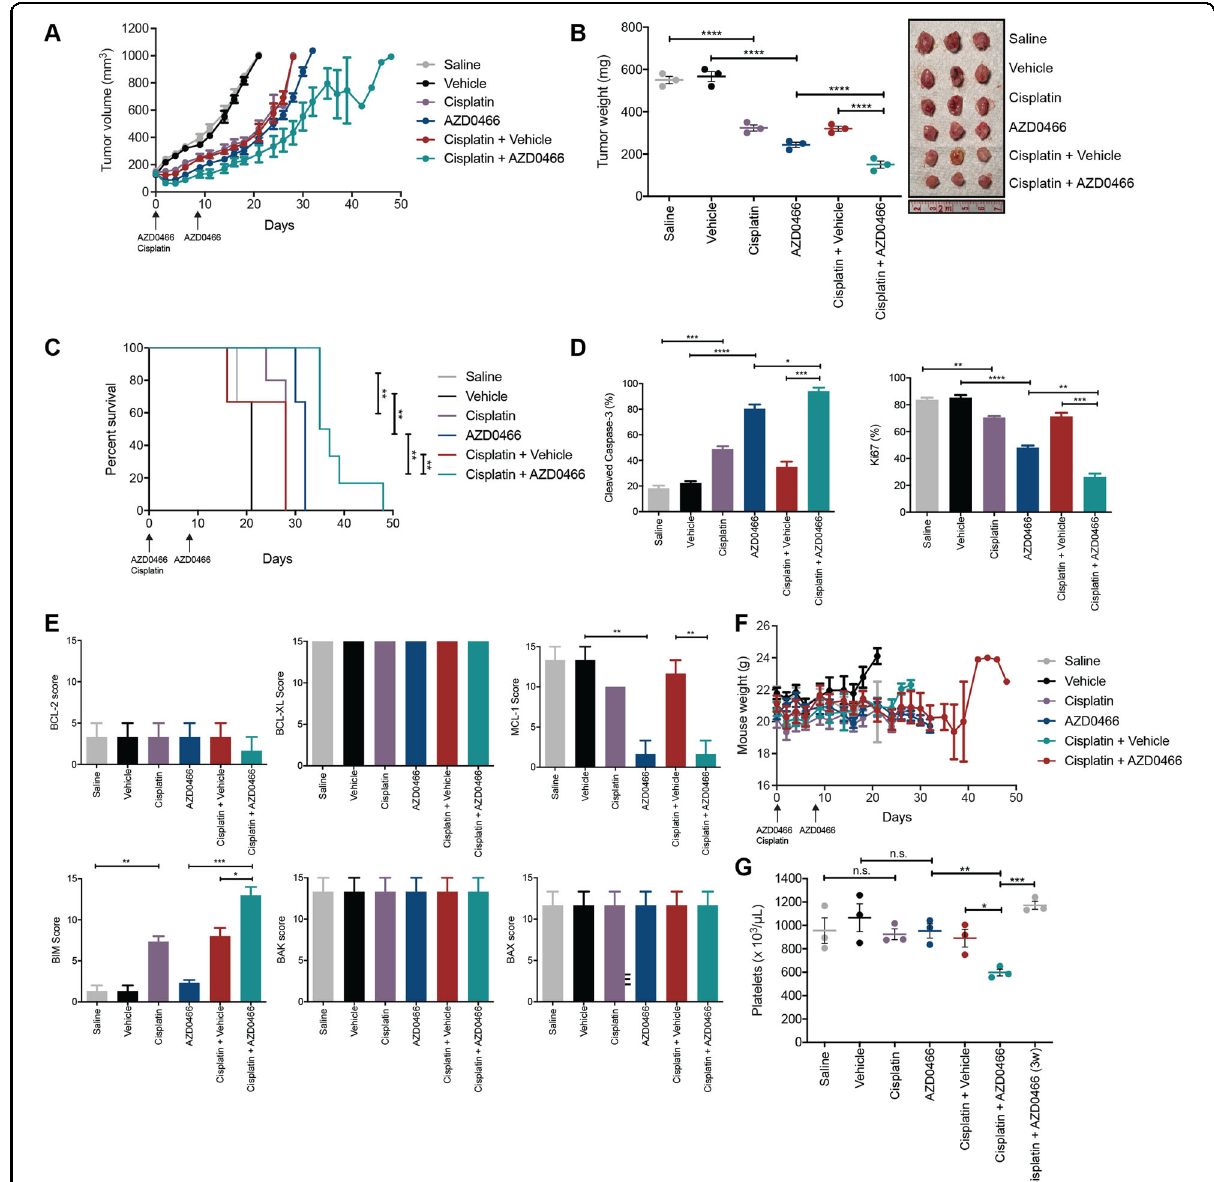
Fig. 4 AZD0466 treatment results in tumor growth control of MPM xenografts. A MSTO-211H xenograft tumor volumes measured during and following treatment with AZD0466 (100mg/kg, days 1 and 8, IV) and Cisplatin (4 mg/kg, day 1 IP), the combination, or appropriate controls. B Tumor masses at Day 19 from start of treatment. Each point is the mass of an individual tumor (photographed) with the bar indicating the mean ± SEM ( n = 3) and signi fi cance determined by Student ’ s t -test (unpaired). C Kaplan – Meier survival curves of mice treated with AZD0466, Cisplatin and combinations of both, with relevant vehicle controls. Survival endpoint was when tumors reached 1000mm 3 as dictated by the ethics approval associated with this experiment. Signi fi cance determined by Log-rank (Mantel – Cox test). D Immunohistochemistry analysis of tumors for cleaved Caspase-3 (CC3) and Ki67. Values represent the mean % postively stained cells for each antibody in fi ve different fi elds of view. Data are mean ± SEM ( n = 3), signi fi cance determined by Student ’ s t -test (unpaired). E Effect of AZD0466 and Cisplatin treatment on indicated BCL-2 family protein expression determined by immunohistochemistry (H-scores) on tumors harvested at Day 19 for indicated BCL-2 family members. Sections were scored for staining by each antibody in 5 different fi elds of view. Data are mean ± SEM ( n = 3 tumors per group), signi fi cance determined by Student ’ s t -test (unpaired). F Body weights of mice were measured during and after the treatment period. Data represent mean ± SEM (n = 6 – 10). G Platelet counts (units per μ L blood) determined 48 h post AZD0466 or vehicle dosing on Day 10 in all treatment groups and in Cisplatin plus AZD0466 treated mice 3 weeks (3w) post start of the treatment phase. Data is mean ± SEM ( n = 3 mice per group), signi fi cance determined by Student ’ s t -test (unpaired).